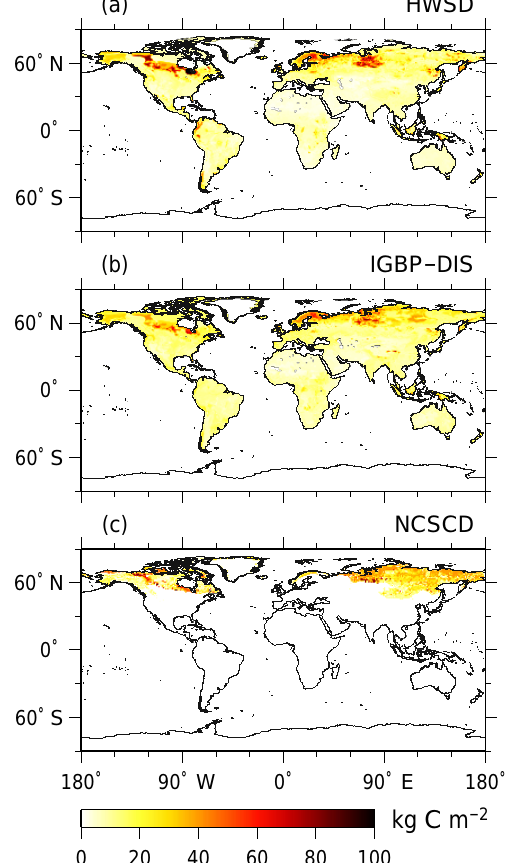
Figure 1. Soil carbon stock in the upper 100cm (kgCm − 2 ) from the observational databases (HWSD, IGBP-DIS, and